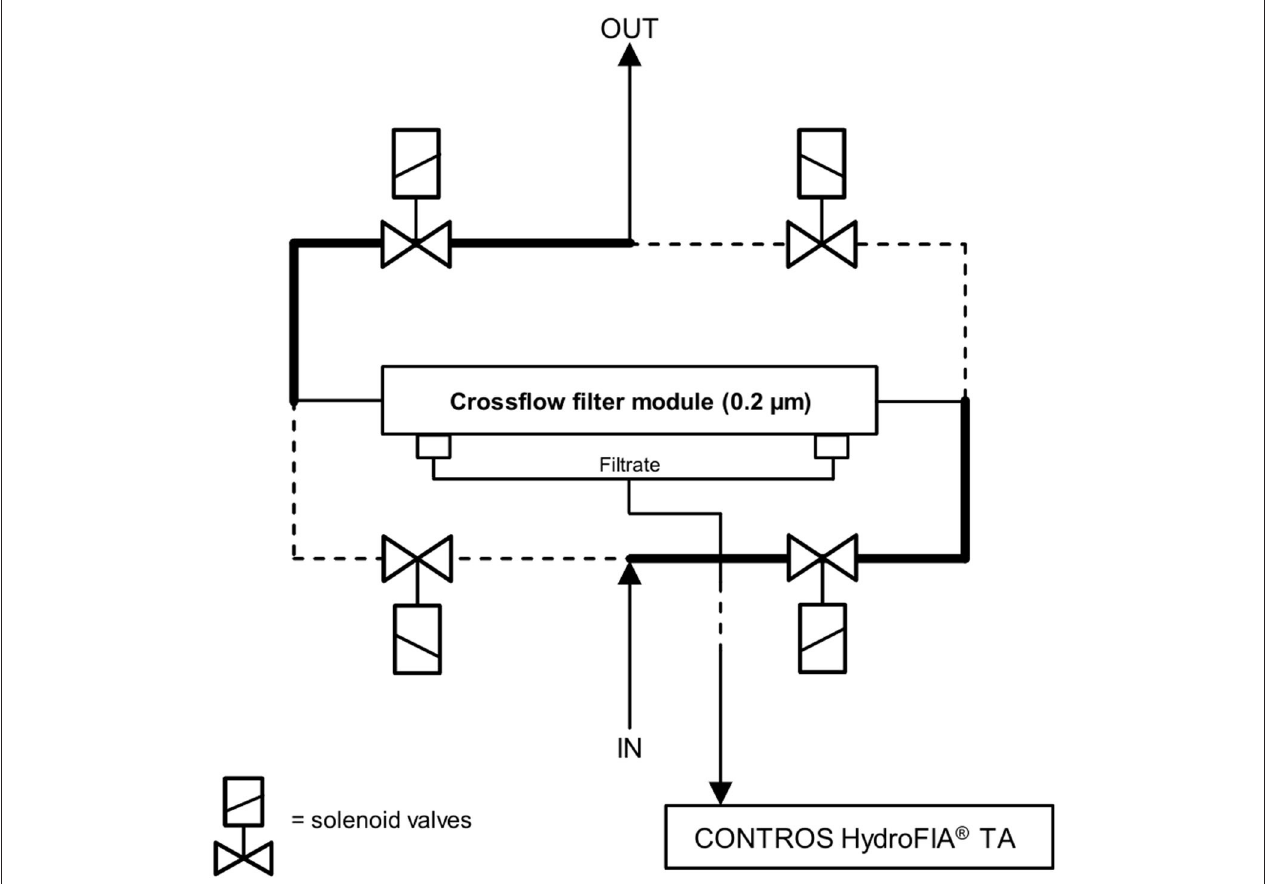
FIGURE 1 | Schematic illustration (not to scale) of the crossflow filter device. The black bold solid lines and the black dashed lines represent the two respective flow paths achieved by opening and closing the solenoid